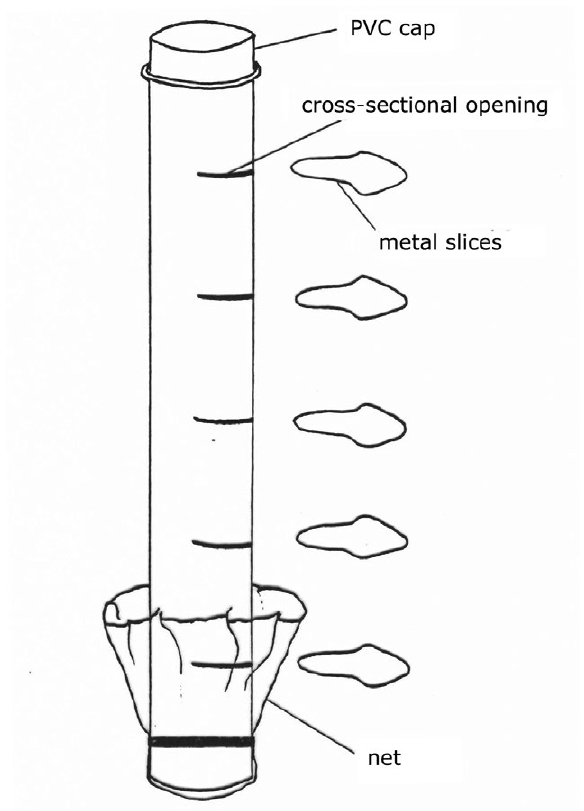
Fig. 2. – Illustration of Core 4 at the start of the experiment of geotaxis and effect of oxygen tension, showing the position of the cross-sectional